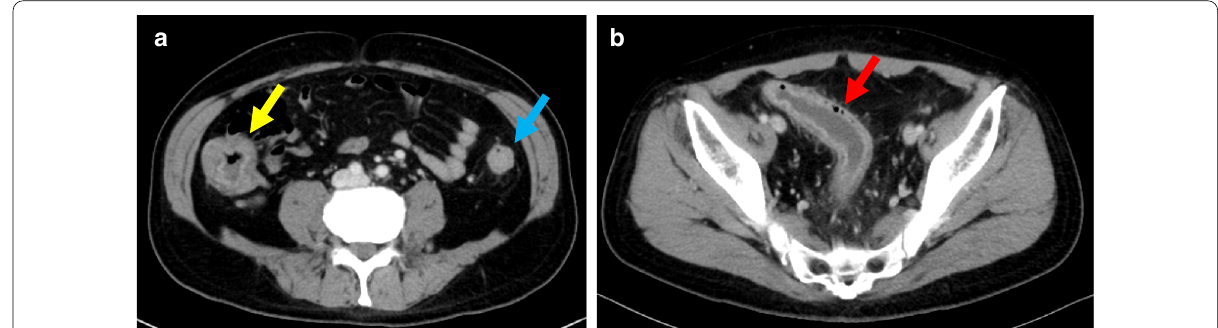
Fig. 3 CT showed edematous and thickening of the colon [ a ascending colon (yellow arrow) and descending colon (blue arrow), and b sigmoid